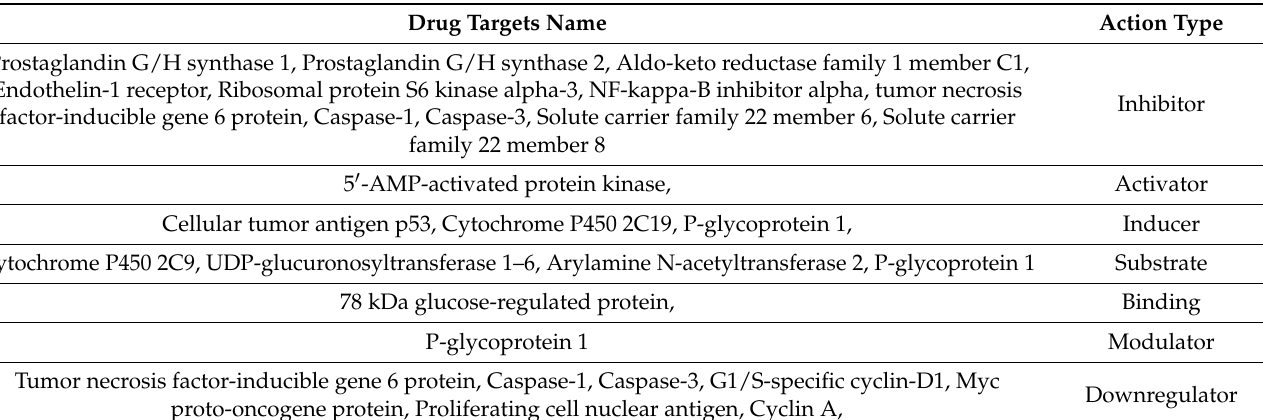
Table 2. Compilation of different therapeutic targets and their action type for ASA [2,3,70,88–92]. Drug Targets Name Action